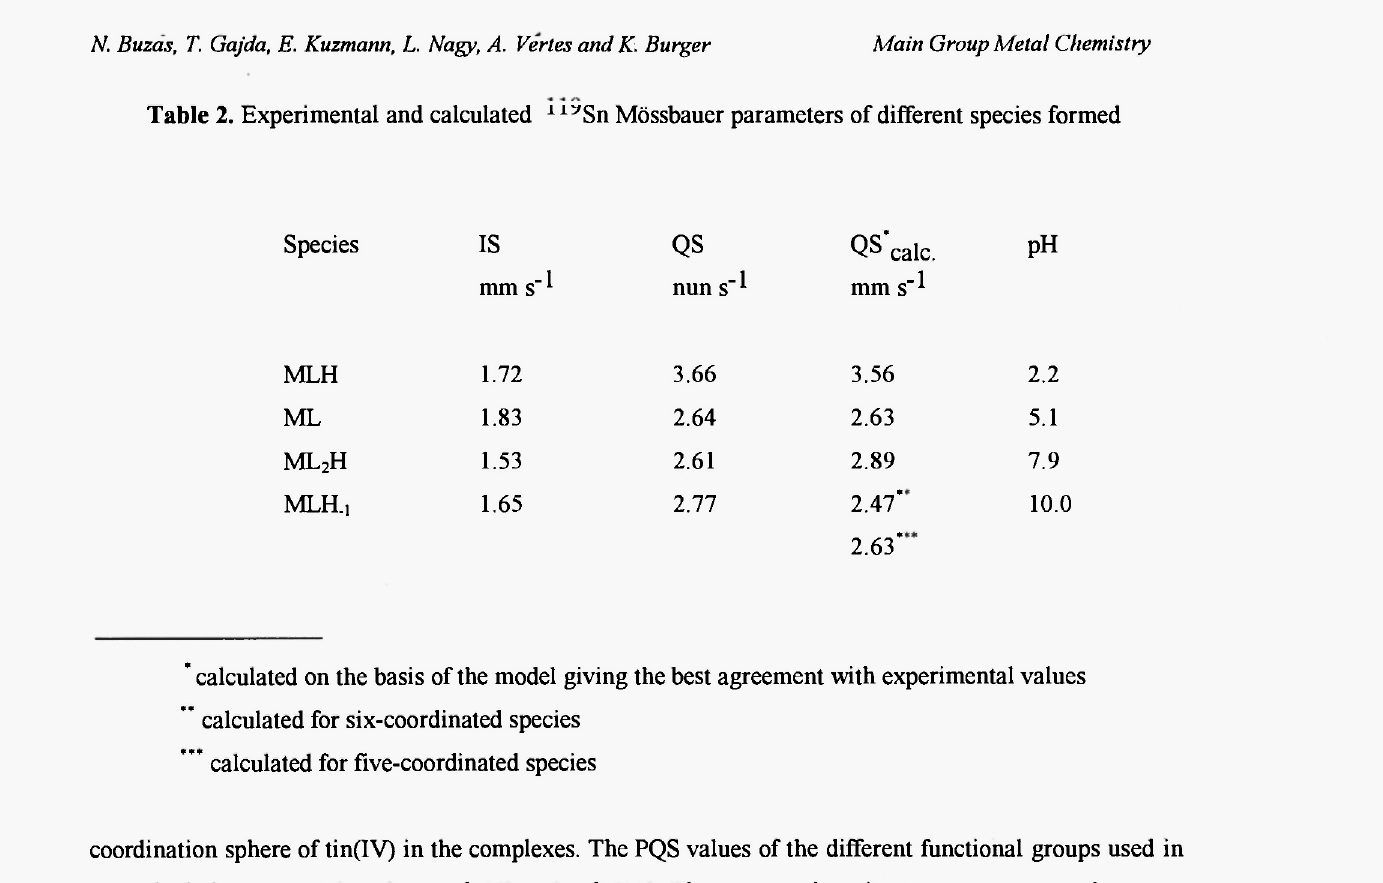
Table 2. Experimental and calculated Mössbauer parameters of different species